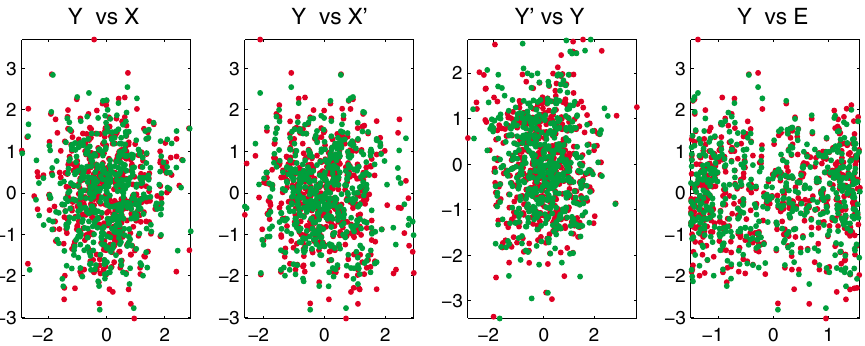
(cid:3) =(cid:3) x x 0